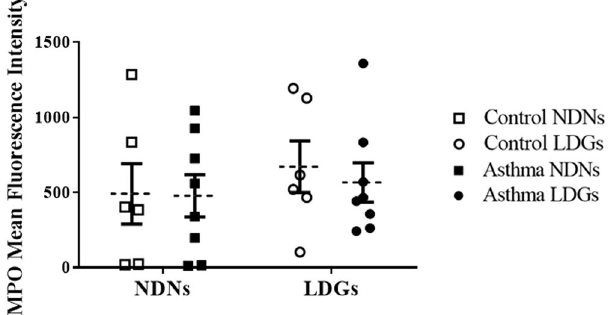
Figure 4. Mean Fluorescence Intensity of MPO in both layers of cells. Each symbol denotes the size mean for a single animal. The mean ± SEM for each studied population is